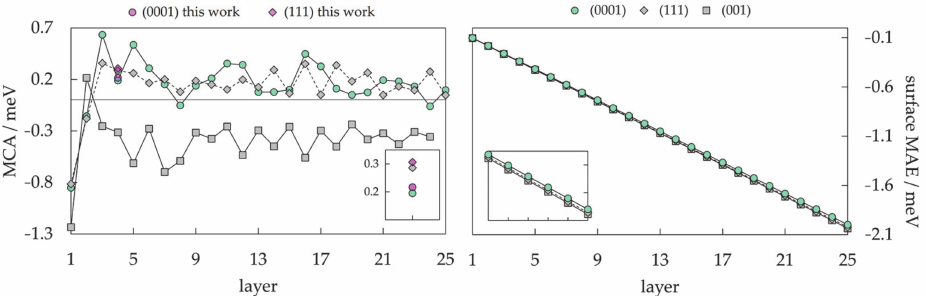
Figure 9. MCA energies for different fcc and hcp Co surfaces of varying thickness calculated at the LSDA level of theory ( left ) and estimated shape anisotropy ( right ). Symbols are the same for both graphs. Data are taken from Zhang (2009) [321]. Legends are the same for both